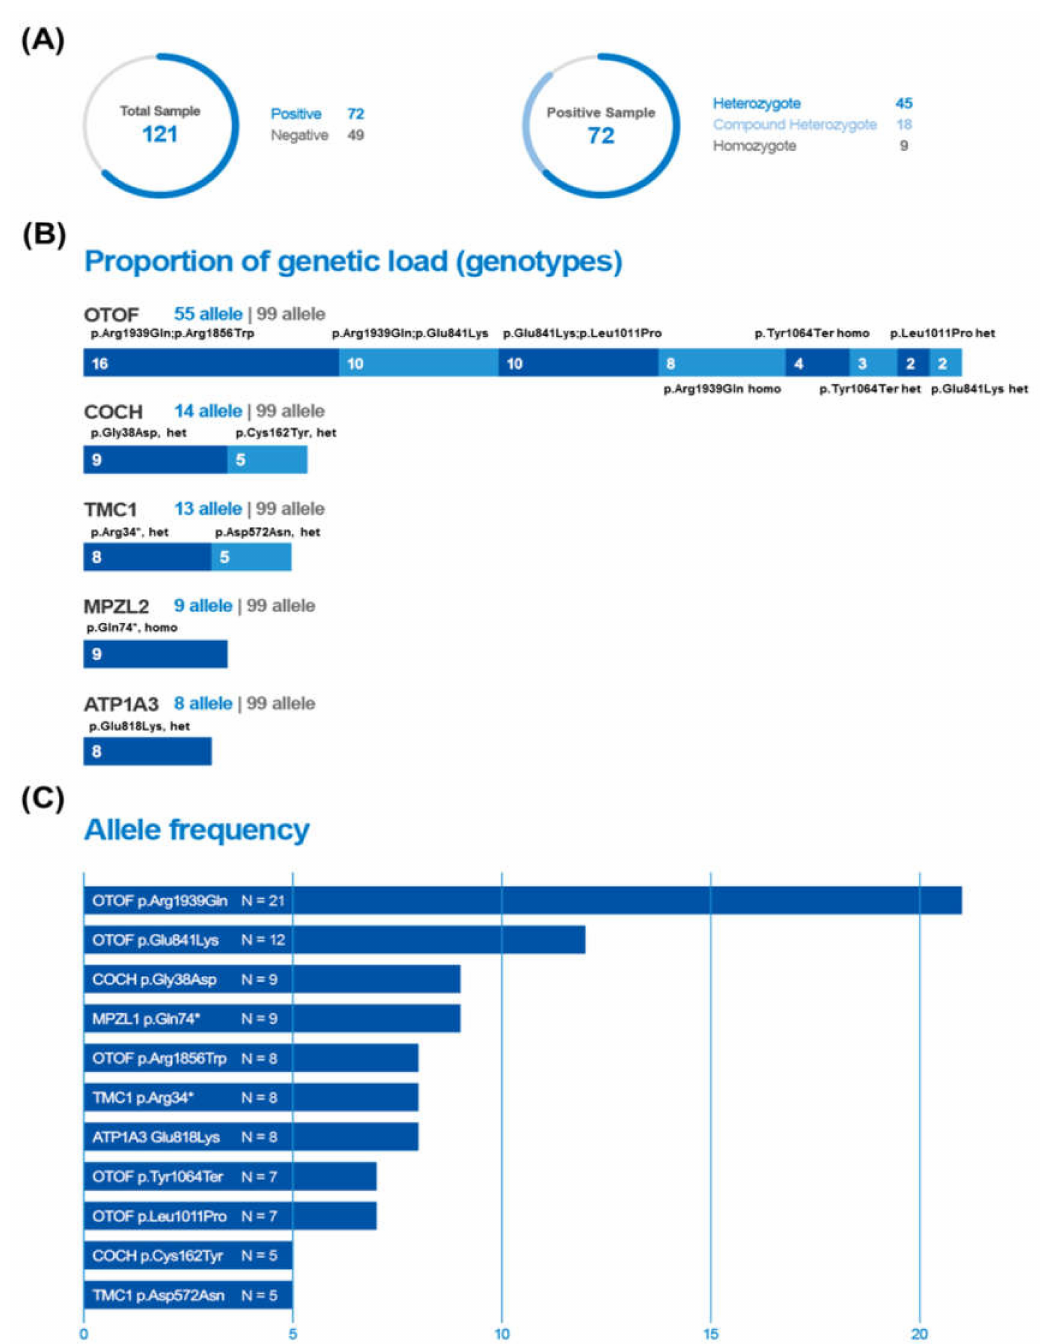
Figure 2. Characteristics of samples for validation of the e ffi cacy of the U-TOP ™ HL Genotyping Kit Ver2. ( A ) Composition of a total of 121 samples (72 samples with variants and 49 negative control samples). Positive samples ( n = 72) carried at least one of the 11 target variants as a single heterozygous ( n = 45, 62.5%), compound heterozygous ( n = 18, 25.0%) or homozygous ( n = 9, 12.5%) state. ( B ) Ninety-nine alleles from 72 positive samples and 15 di ff erent genotypes. The proportion of genetic load was depicted in the order of frequency of genotype. For example, the proportion of genetic load of OTOF among the 99 alleles was 55.6%, with 8 di ff erent genotypes. ( C ) Allele frequency according to each variant. The variant p.Arg1939Gln of OTOF was the most common, with an allele frequency of